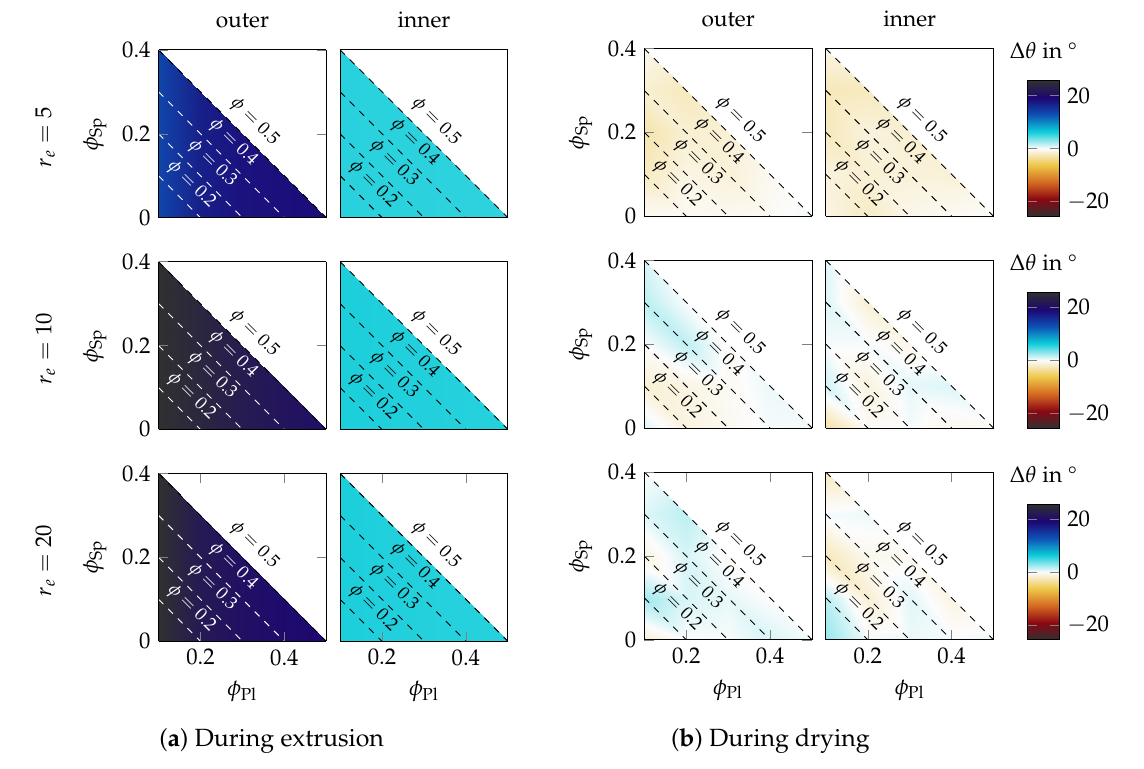
Figure 10. Quantification of the reorientation ∆ θ during drying ( b ) in direct comparison to the re- Figure 3.3. Quantification of reorientation ∆ θ during drying (b) in direct comparison to the reorien- orientation that occurred during the extrusion process ( a ). Each heat map shows the influence of the composition. From top to bottom, the aspect ratio r e of the platelets is varied.